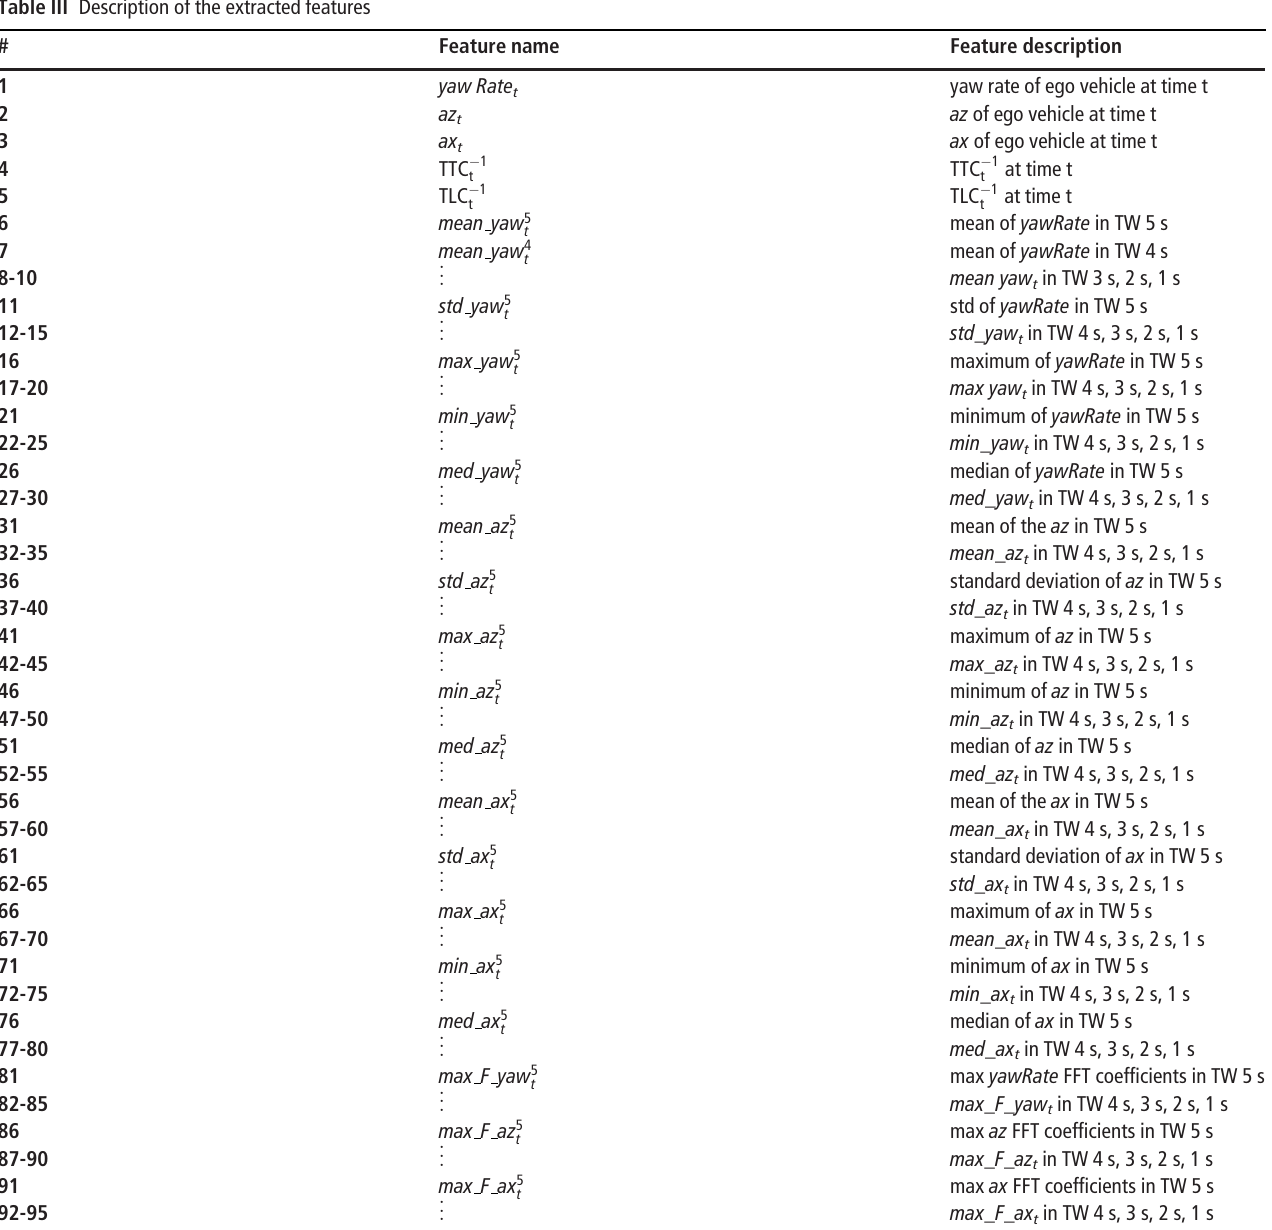
Table III Description of the extracted features